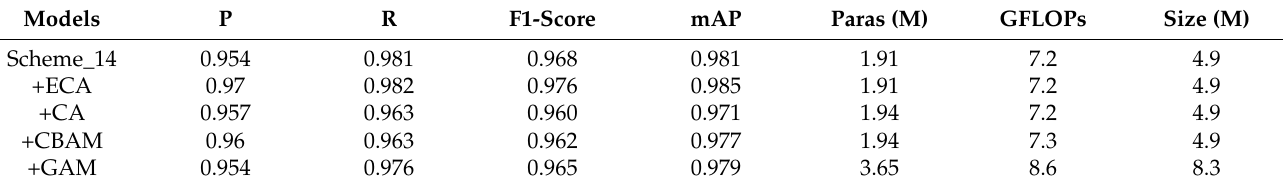
Table 5. Comparison experiments of attention